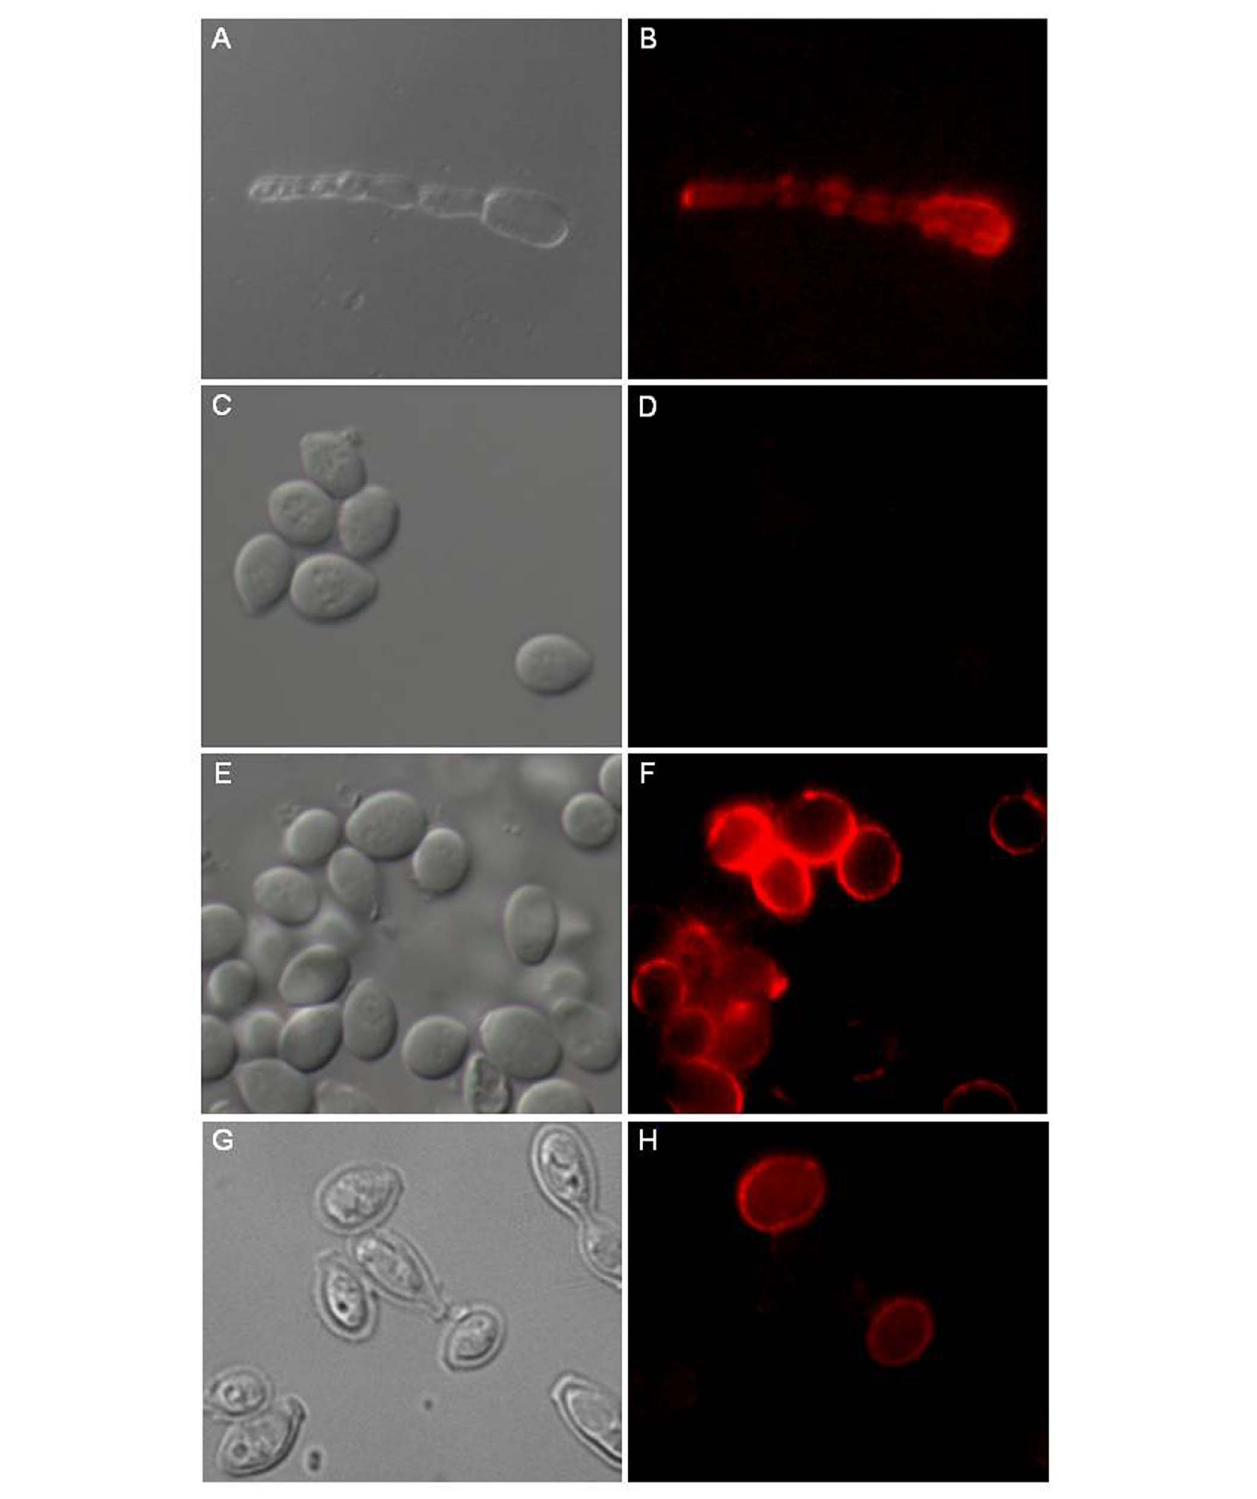
FIGURE 4 | Distribution of GlcCer species on L. prolificans surface. The anti-GlcCer mAb revealed the presence of GlcCer species on the mycelium surface (B) . The anti-GlcCer mAb was not able to bind to the surface of the intact conidium (D) . After incubation in RPMI medium for 6 h as a swollen conidium (F) or treatment with 1M NaOH (H) . GlcCer species were identified on the conidial surface with the anti-GlcCer mAb. In (A , C , E,G) was differential interferencial contrast microscopy (DIC). Bar: 10 µ m.